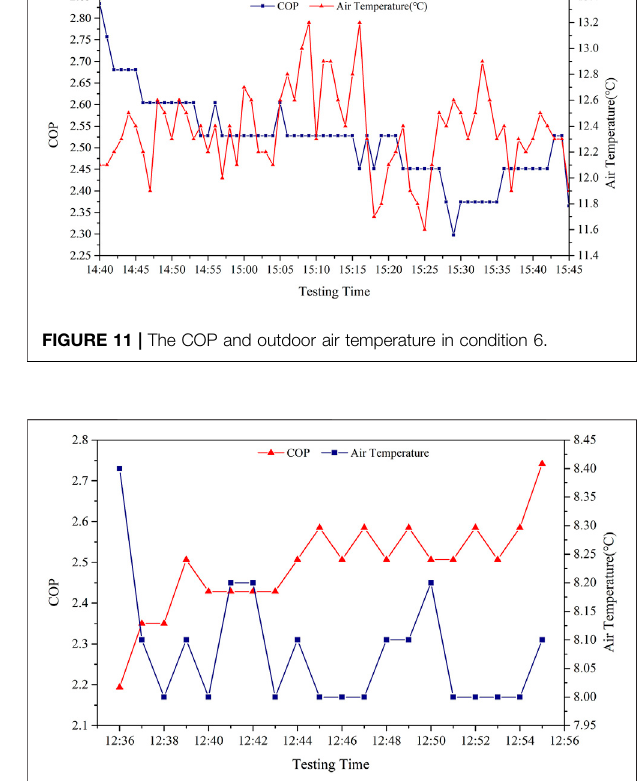
FIGURE 9 | The COP and outdoor air temperature in condition 4.